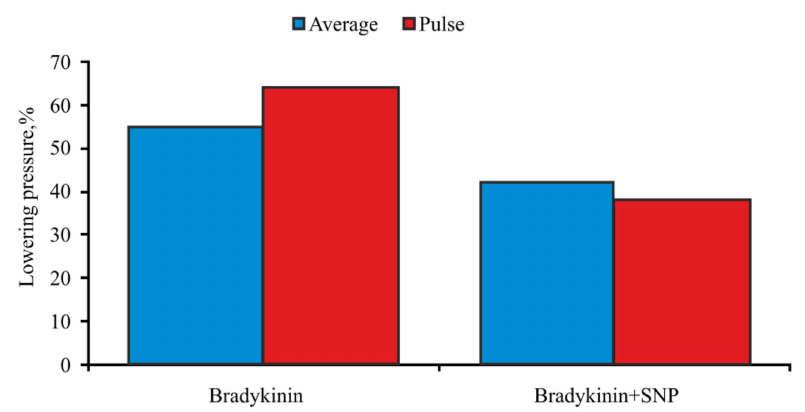
Figure 13. Hemodynamic effects of